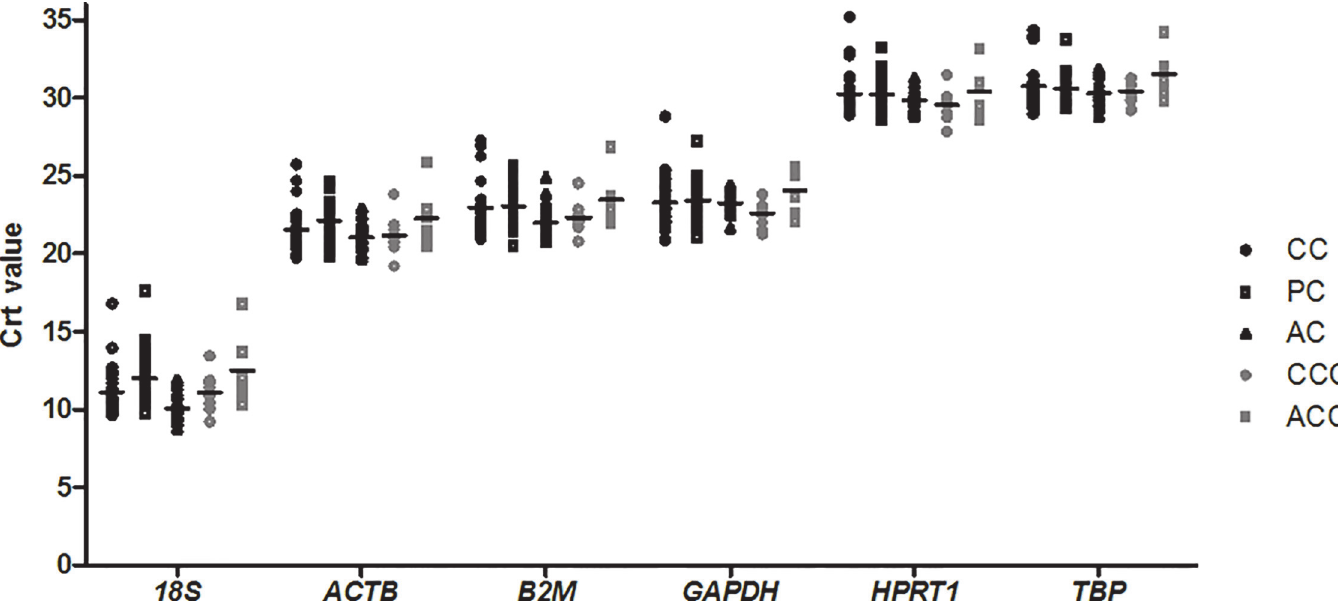
Fig 1. RT-qPCR detection of the expression levels of six reference genes. A lower cycle threshold value (Crt) indicates higher gene expression. CC: central cuff (injured supraspinatus tendon) samples of cases; PC: posterior superior cuff samples of cases; AC: anterior cuff samples of cases; CCC: central cuff samples of controls; ACC: anterior cuff samples of